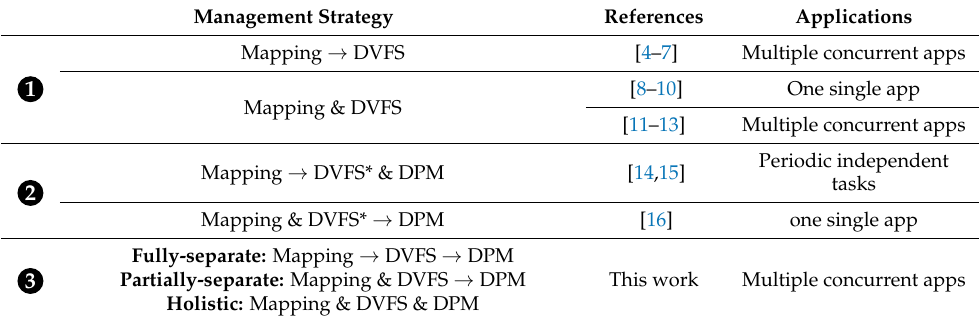
Table 1. Comparison of applying mapping, DVFS and DPM in